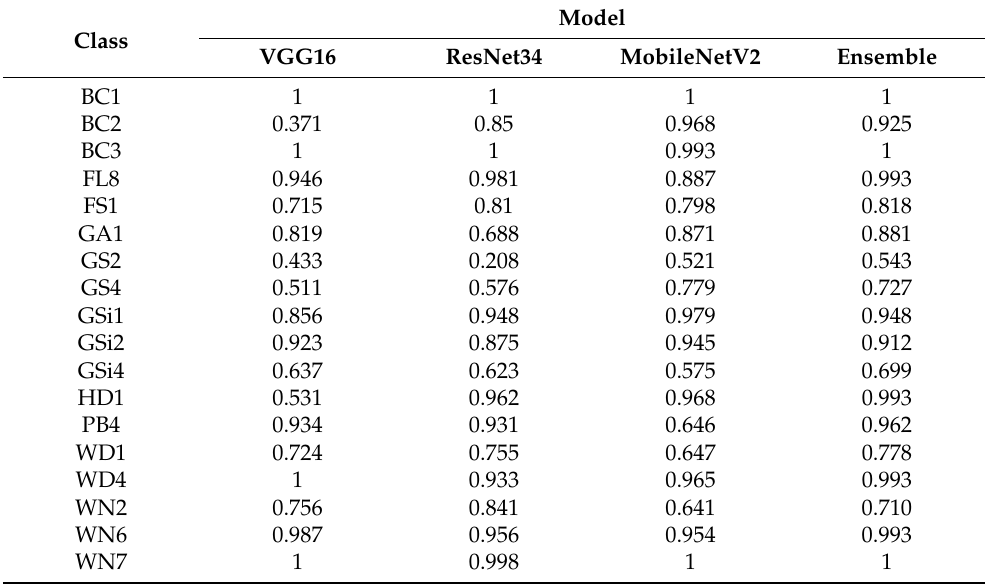
Table 3. Class-wise accuracy of base-learners with VGG16, Resnet34, MobilenetV2, and Ensem- ble models.